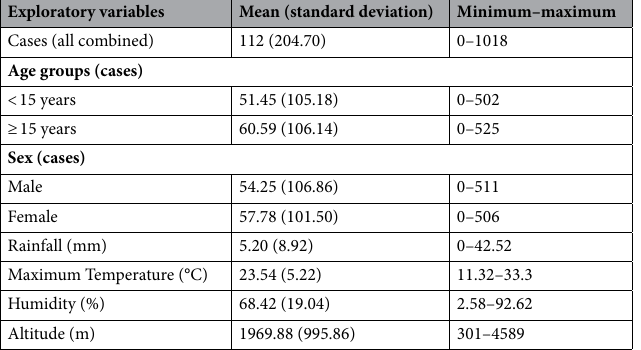
Table 2. Monthly means of common colds by demographic and environmental variables in Bhutan, 2010– 2018.